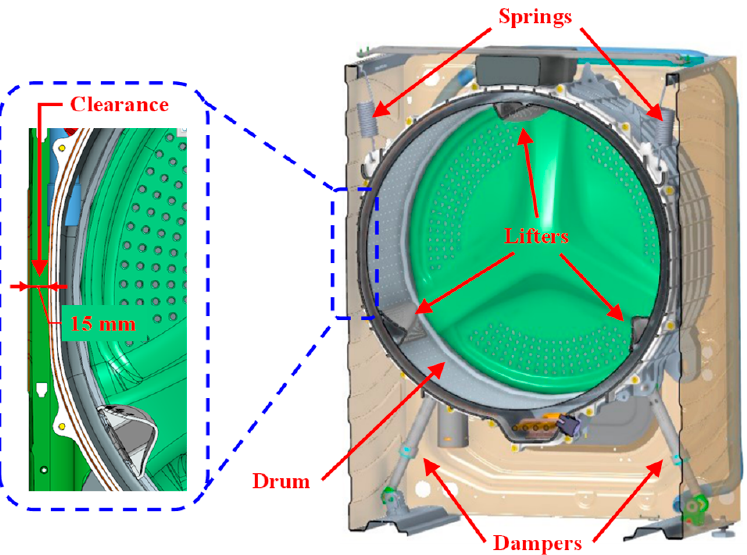
Figure 1. View of a horizontal-axis washing machine ( right ) and magnification of the mechanical clearance ( left ).